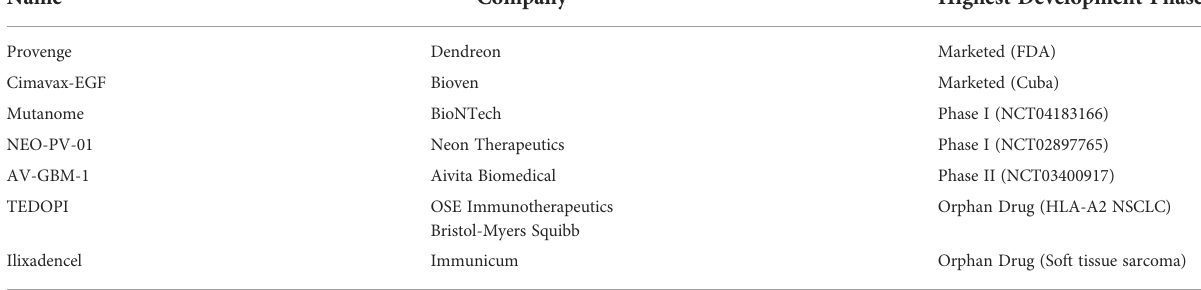
TABLE 5 Research progress of therapeutic cancer vaccines (Up to April